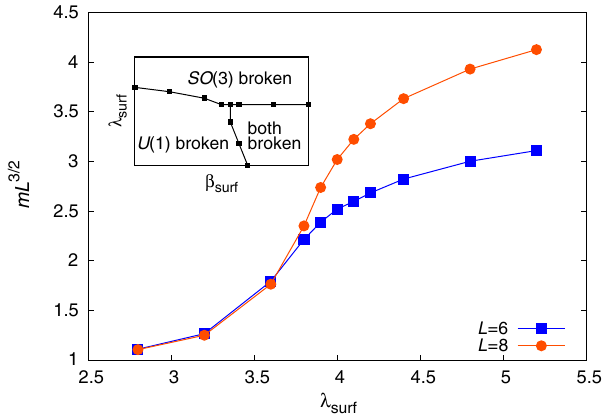
FIG. 5. Current-current correlators of the entire system, multi- FIG. 4. The inset shows the phase diagram of the surface of the plied by L 2 , used to detect symmetry breaking of the bosons on binding phase, without a Zeeman field. It is obtained by tuning the surface. This quantity is constant when the boson U ð 1 Þ the bulk parameters deep into the binding phase and then varying β and λ only on the surface. We find that in this model our surface symmetry is preserved and increases linearly with system size when it is broken on the surface. Parameters used are the same as always spontaneously breaks a symmetry. At small β and λ , surf surf in Fig. 4. We see that there is a phase transition at λ the boson U ð 1 Þ symmetry is broken and the bosons condense into a superfluid, while at large λ the spin SO ð 3 Þ symmetry is surf broken and the spins align into a ferromagnet. At small λ and surf large β , both symmetries are broken. The main plot shows surf ¼ 0 . We show surface magnetization on a sweep in λ for β surf surf mL 3 = 2 , which is independent of system size in the disordered phase and grows with system size in the ordered phase. We can clearly see that the SO ð 3 Þ symmetry is broken as λ is increased surf past a value of approximately 4. All data in this section are taken ¼ 0 , λ ¼ 5 . 2 . with β bulk bulk